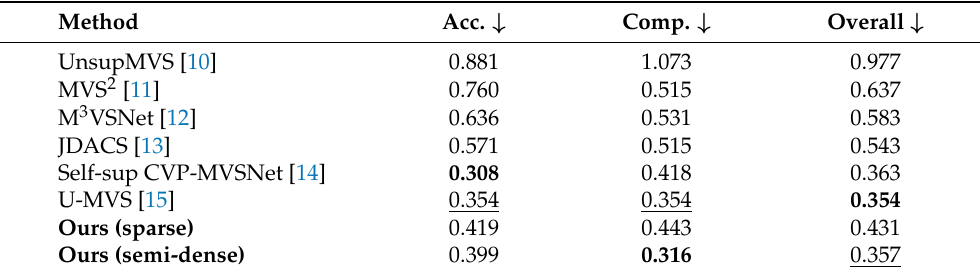
Table 1. Quantitative results of our method against self-supervised MVS methods on the DTU dataset (lower is better). The best results are in bold, while the second ones are underlined.